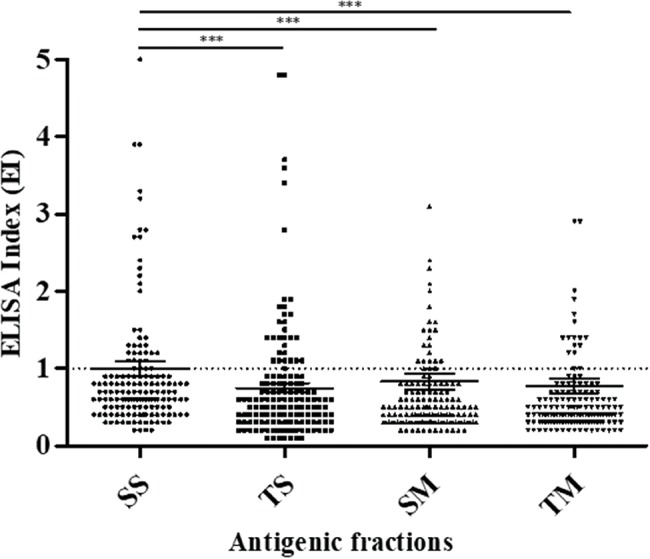
Specific anti-Strongyloides IgG expressed as the ELISA index (EI) for serum samples from transplant candidates using S. venezuelensis antigenic fractions (SS, TS, SM and TM). The dashed lines represent the positivity threshold (EI >1.0).